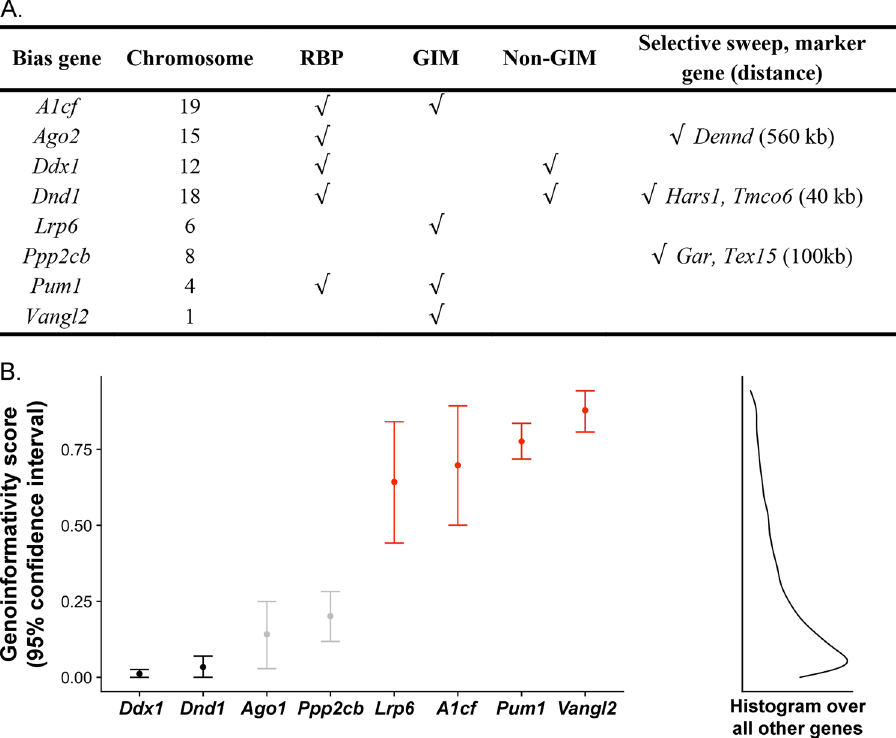
Figure 4. RNA-binding proteins and genoinformativity markers. ( A ) RNA-binding proteins (RBPs) and genoinformativity markers (GIMs). Source of information: Chromosome (informatics.jax.org), RBPs 18 , and GIMs, non-GIMs and sweeps 12 . The approximate distance (kb) of “bias” genes from the center of the sweep is provided in parentheses. The Ppp2cb transcript was detected but did not reach the threshold to determine whether it is a GIM or non-GIM 12 . The ninth ‘bias’ gene, apolipoprotein B transcript ( Apob ), which is not known to be an RBP, was not detected 12 . ( B ) Genoinformativity scores. Left: genoinformativity scores and 95% confidence intervals 12 are displayed. Four are confident GIMs (red), two confident non-GIMs (black), and two “remaining genes” (gray). Right: the kernel density showing that most mouse genes had low genoinformativity